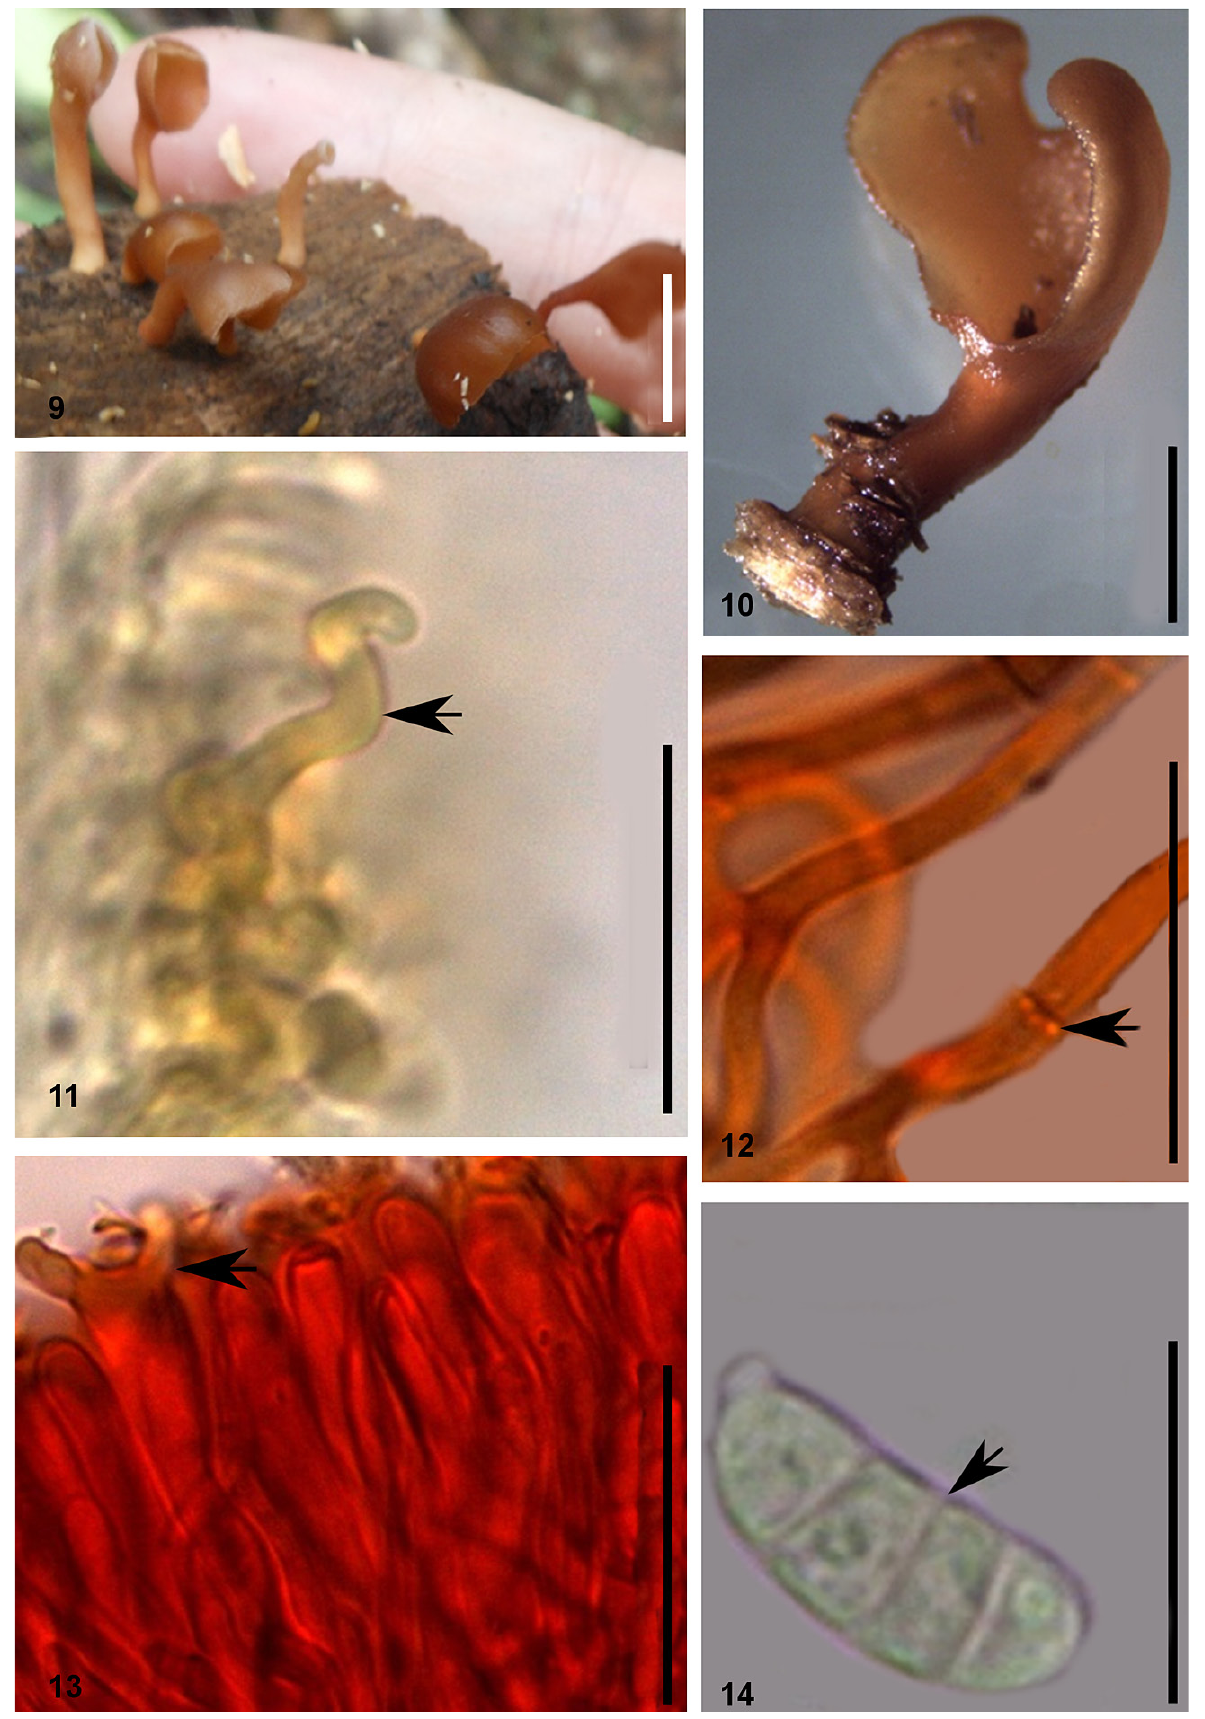
Figure 9–14. Dacryopinax elegans . 9, 10. Basidiomata when fresh (HUEG 10499), scale bars = 1 mm and 2 mm respectively. 11. Marginal hairs (black arrow), scale bar = 10 µm. 12. Hyphae without clamp-connection (black arrow), scale bar = 10 µm. 13. Hymenium with immature metabasidia (black arrow), scale bar = 10 µm. 14. Basidiospore with 3 septa (black arrow), scale = 10